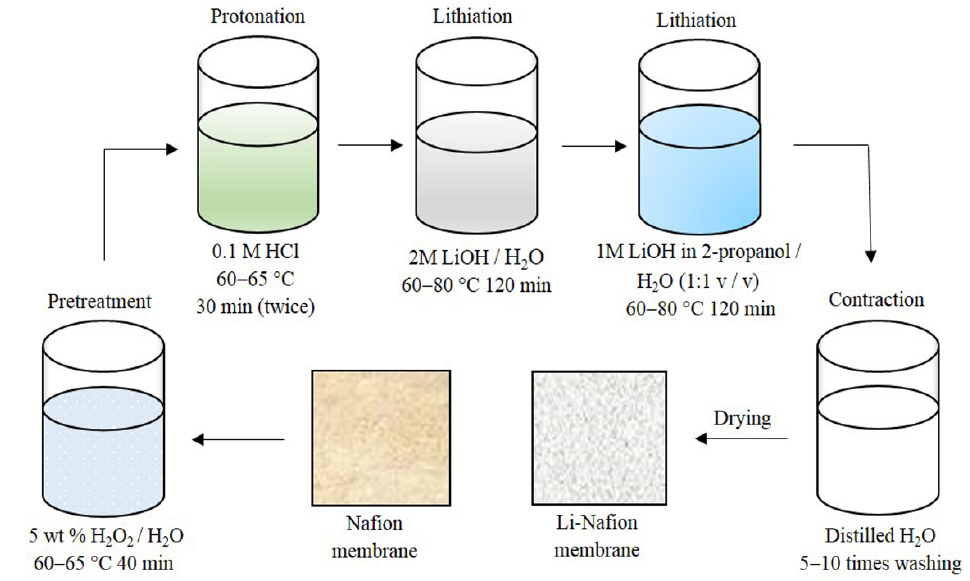
Figure 2. Scheme of the Nafion membrane lithiation